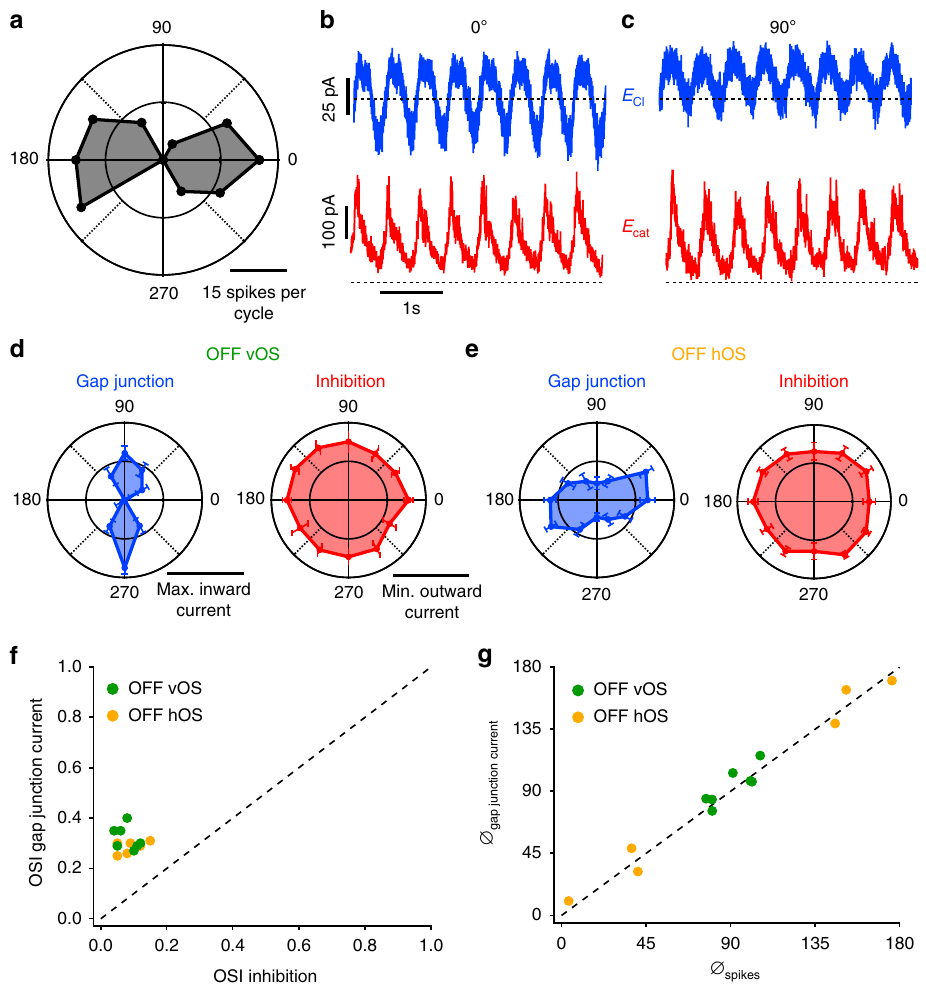
Fig. 6 Synaptic responses to drifting gratings in OFF OS RGCs. a Polar plot of drifting grating responses of an example OFF OS RGC. b , c Raw traces of recorded currents at E Cl (blue) and E cat (red) currents at preferred ( b ) and null ( c ) orientations, respectively, for the cell in a . d , e Polar plots of population averaged normalized maximum inward gap junction (blue) and minimum outward inhibitory currents (red) for OFF vOS ( n = 7, d ) and OFF hOS ( n = 6, e ) RGCs. Error bars are SEM across cells. Inhibitory currents were obtained by subtracting the E Cl current from E cat current. f OSI of gap junction current plotted against OSI of inhibition for OFF vOS ( n = 7) and OFF hOS ( n = 6). g OS angle of gap junction ( θ gap junction current ) current plotted against OSI of cell attached spikes ( θ spikes ) for OFF vOS ( n = 7) and OFF hOS ( n =